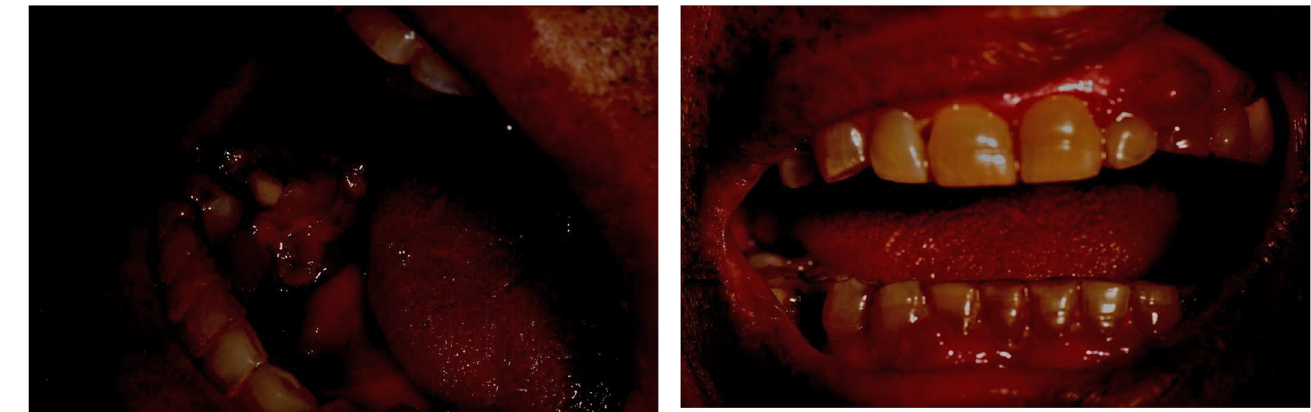
Fig. 1. Lingual lesion found on 46 when fi rst discovered.